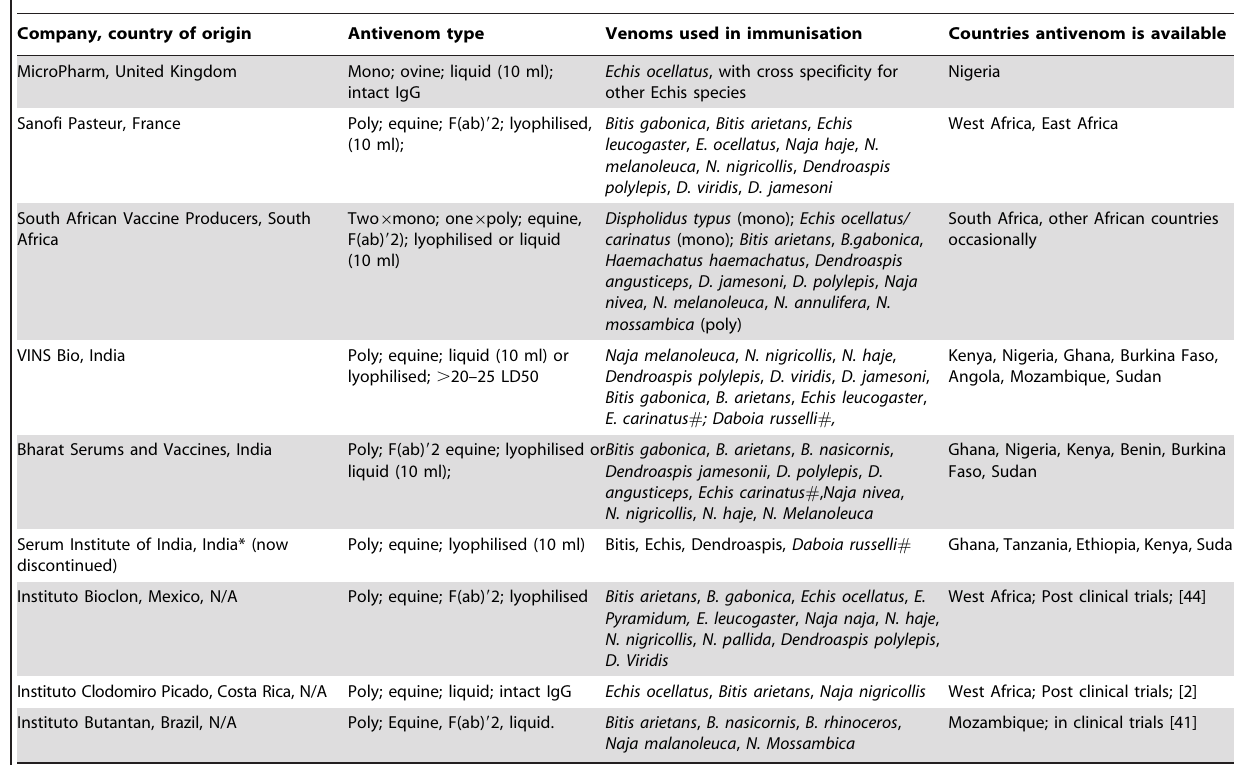
Table 1. Recent and current sub-Saharan African antivenom